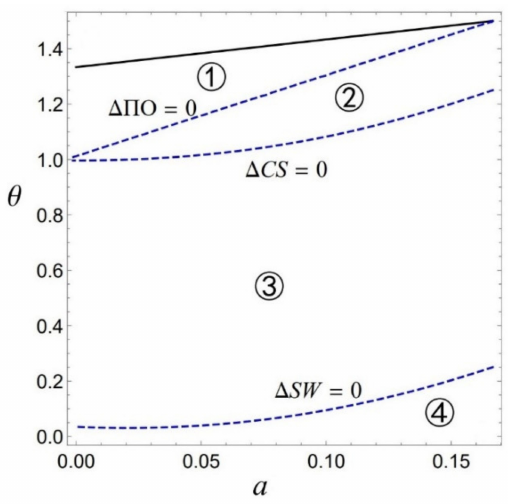
Figure 3. Effects of merger with passive